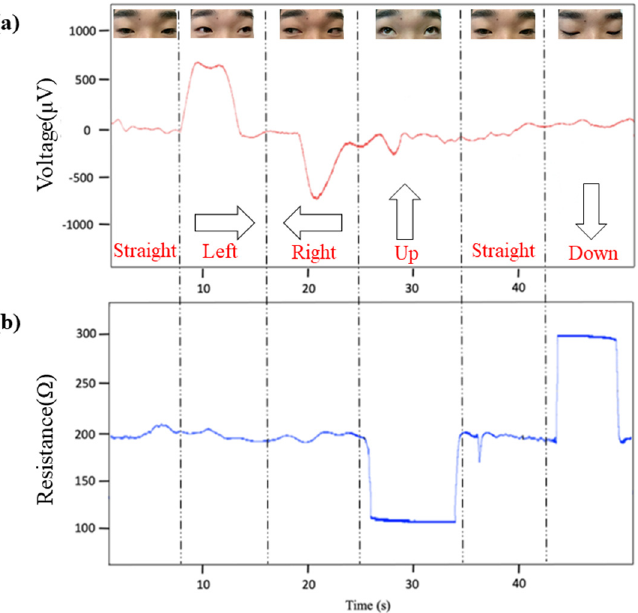
Figure 6. Presentation of the electrophysiological signals in diverse eye movement states. ( a ) EOG signal. ( b ) Strain signal.